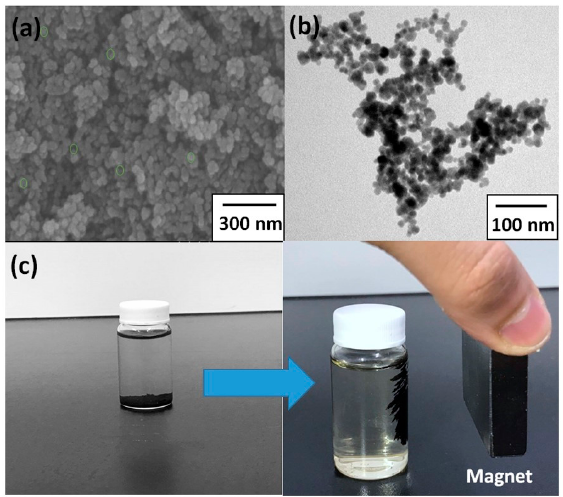
Figure 7. ( a ) FE-SEM and ( b ) Transmission electron microscopy (TEM) images of Fe 3 O 4 NPs synthesized through coprecipitation. ( c ) Magnetic Fe 3 O 4 NPs in the solution (left: Fe 3 O 4 precipitated out of the solution and dropped to the bottom; right: Fe 3 O 4 accumulated on the side of the bottle because of the magnet).